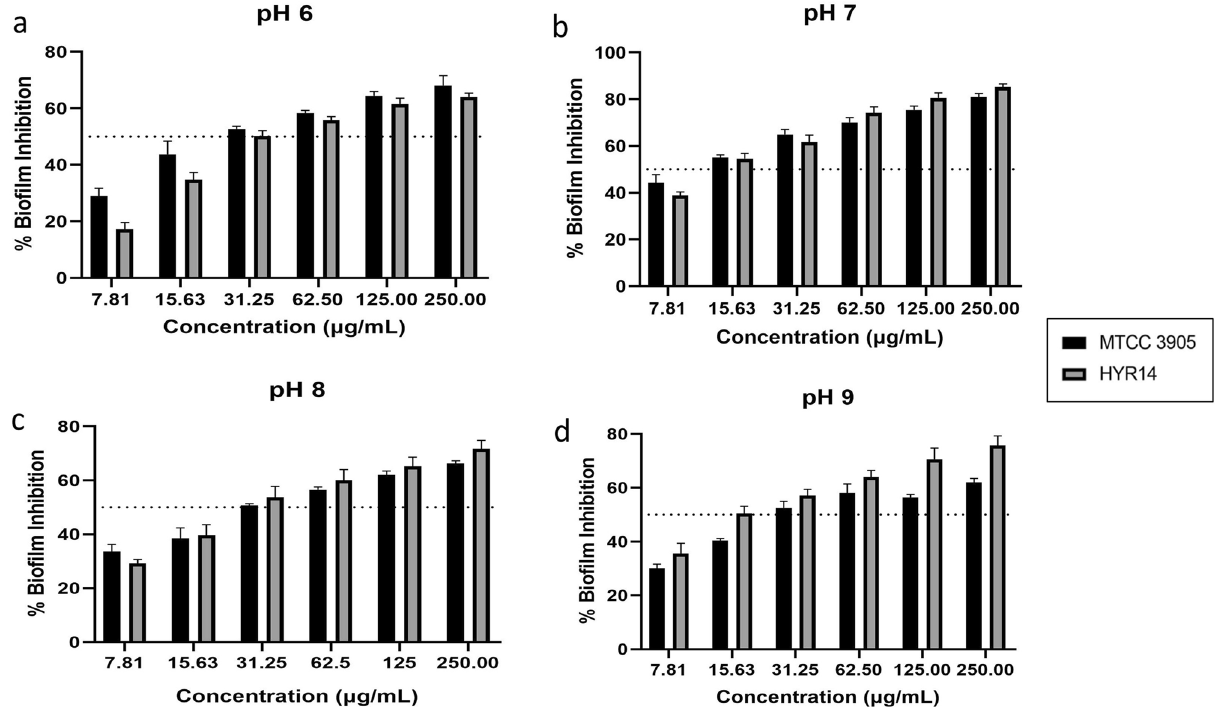
Figure 8. Percentage inhibition of V. cholerae MTCC 3905 and V. cholerae HYR14 biofilm formation at ( a ) pH 6, ( b ) pH 7, ( c ) pH 8, and ( d ) pH 9 after exposure to various concentrations of cellulose acetate phthalate nano- formulation of 2M4VP (CAP-2M4VP) for 24 h at 37 °C. At the concentration of 31.25 μg/mL, CAP-2M4VP inhibits about 50% of biofilm formation by V. cholerae MTCC 3905 and HYR14 at pH 6, pH 7, pH 8 and pH